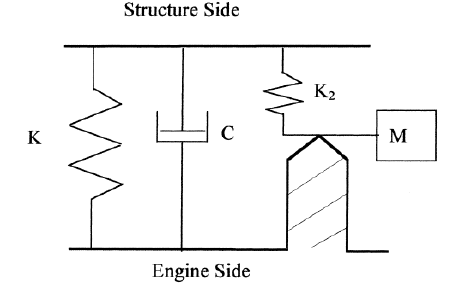
Fig. 6. Mechanical model of the adaptive hydraulic engine mount